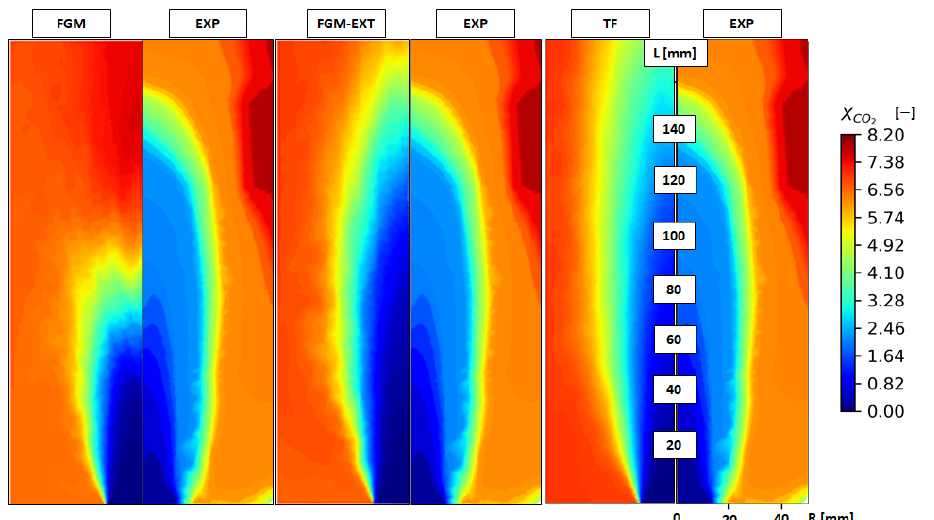
Figure 9. Contour maps of CO 2 mole fraction ( X CO with experimental maps adapted from